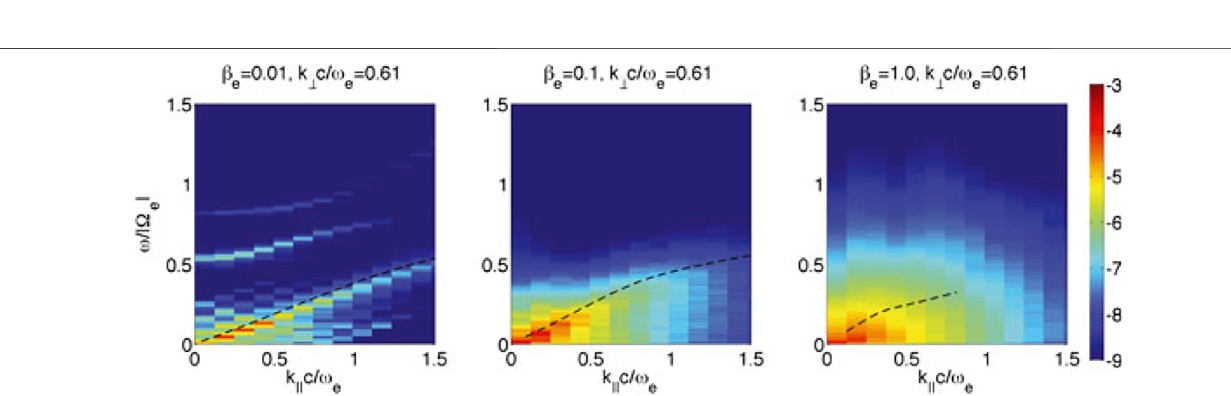
Frontiers in Physics |